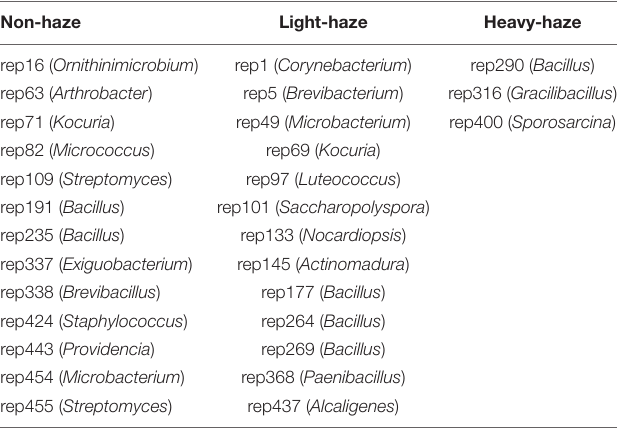
TABLE 2 | The unique representatives with antimicrobial activity during various haze-level days.